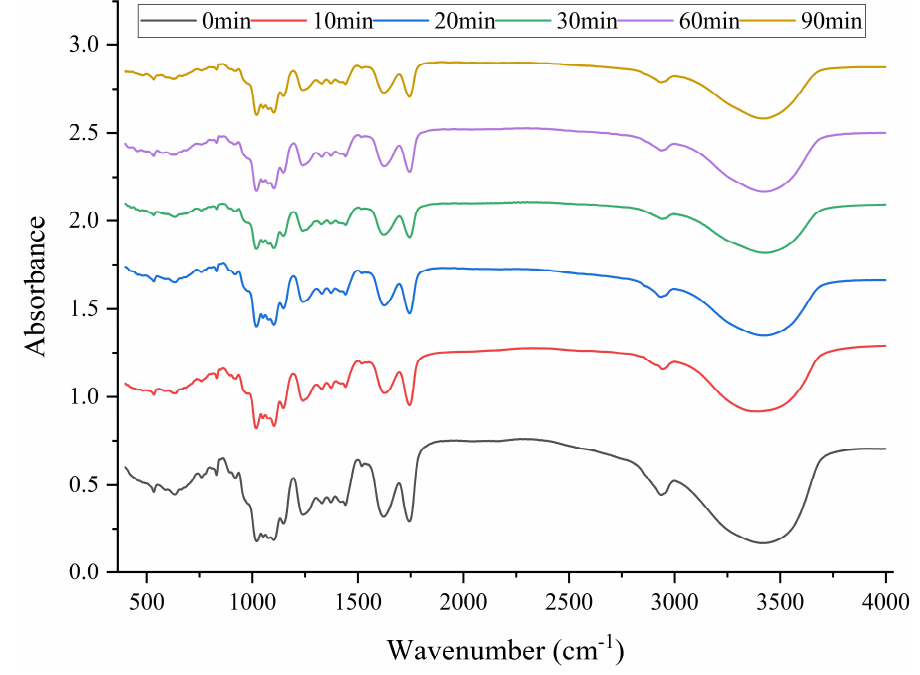
Figure 2. The FT-IR absorption peaks of different SBP samples.